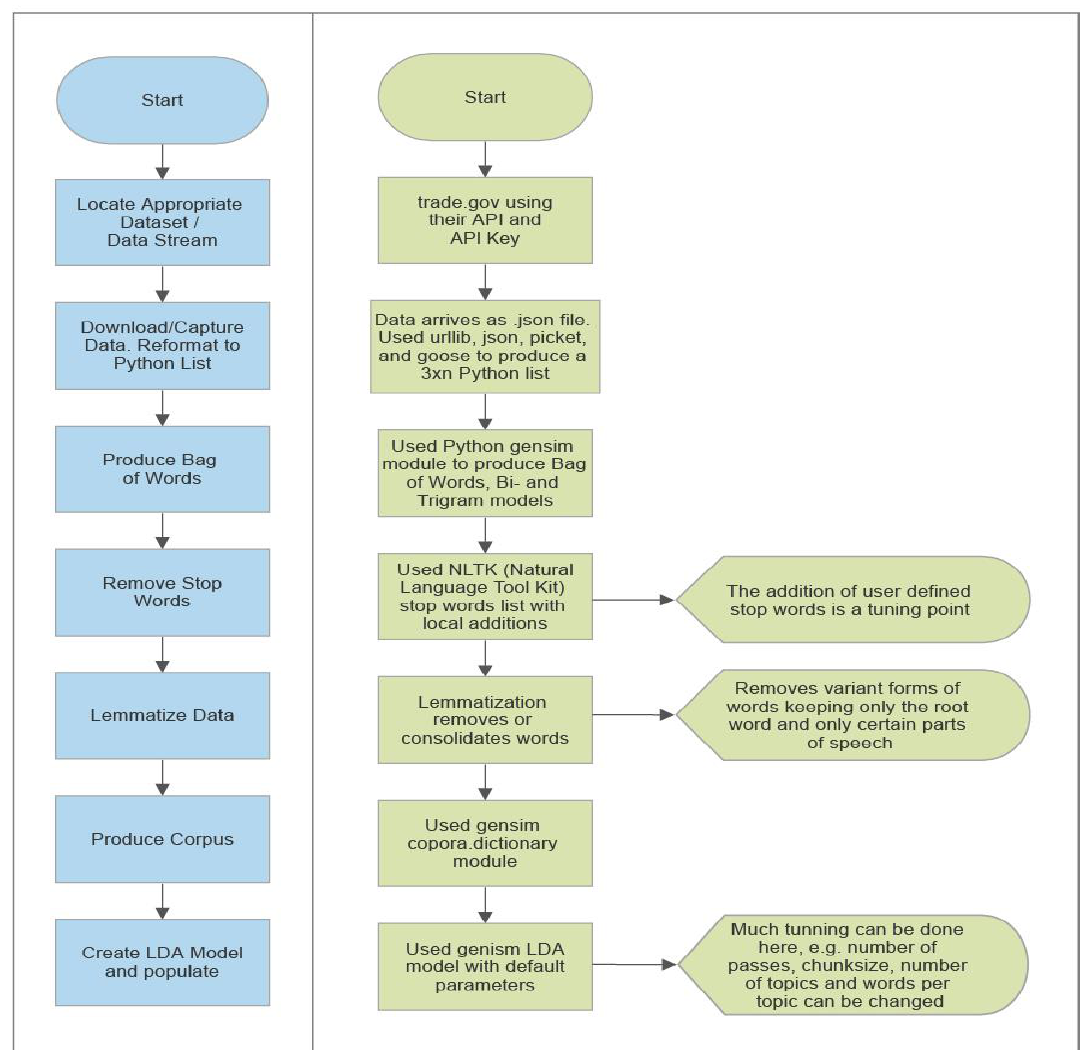
Figure 1. Overall model of LDA technique.